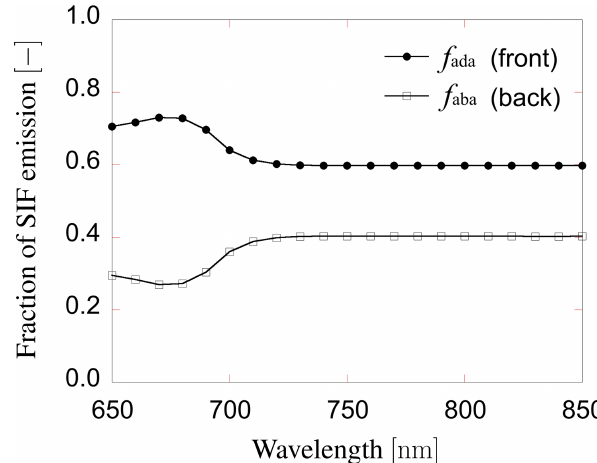
Figure 6. Spectral leaf reflectance and transmittance, woody re- flectance, and soil reflectance used in the sensitivity analysis. These optical data were constructed by averaging the spectral data in the literature and publicly available data sets (Kobayashi, 2015b).